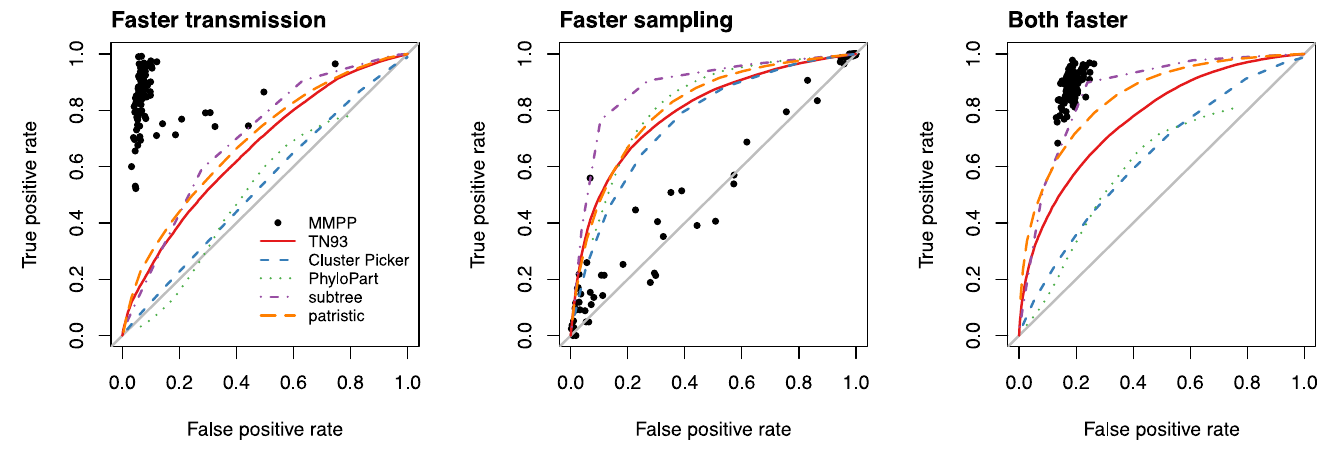
Fig 2. Performance of MMPP and five nonparametric clustering methods on simulated data. Sequence data were simulatedunder three scenarioswhere the minority subpopulationhad (1) a faster transmissionrate (left); (2) a faster samplingrate (centre), or; (3) both faster rates of transmission and sampling(right). The x - and y -axes correspond to the false and true positive rates of classifyingindividuals into the minority subpopulation, respectively. Each point represents the outcome when the MMPP model was appliedto one of 100 replicatesimulations. Each line represents the receiver-operator characteristic curve for one of the five nonparametric clusteringmethods (see figure legend),where different false and true positive rates were obtainedby varying a threshold parameter of the method.